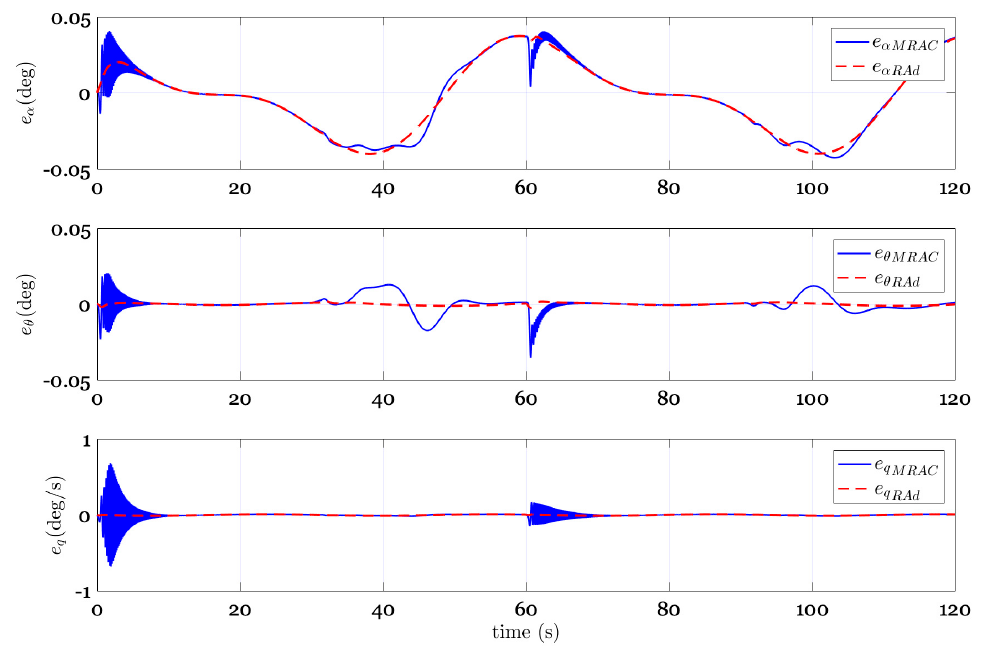
Figure 11. Status errors from MRAC and robust adaptive controller with ρ λ = ρ θ = 10.